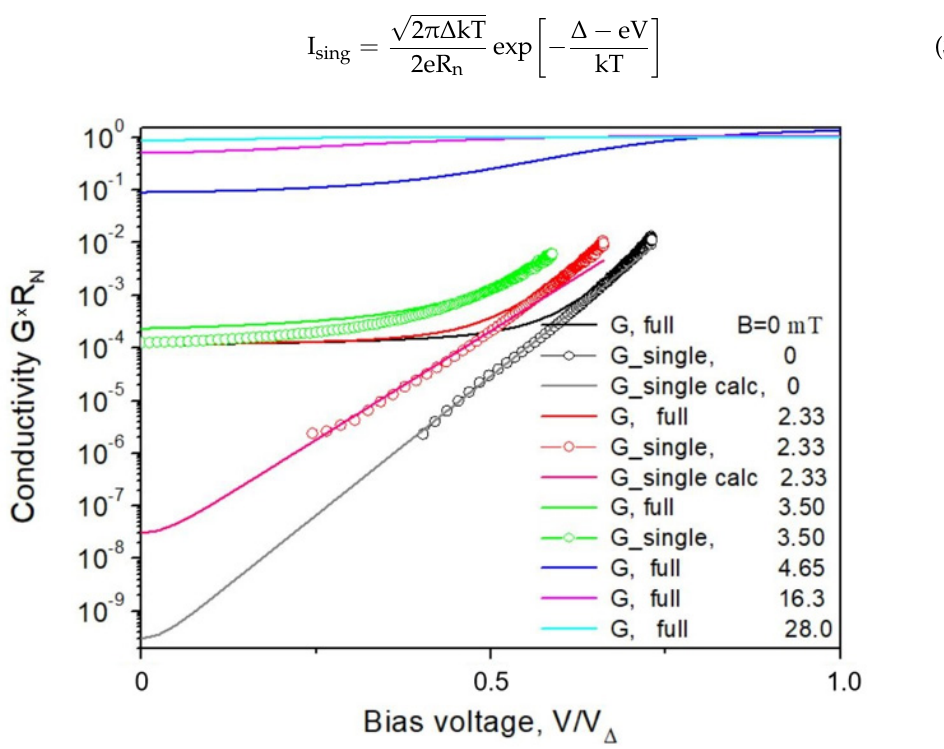
Figure 5. Normalized conductivity G × R n in logarithmic scale dependence (experimental with circles and calculated lines) on normalized voltage V/V ∆ for magnetic field from 0 to 28 mT. Curves with label “single” correspond to single-electron tunneling with subtracted Andreev current, and label “full” corresponds to full current including both Andreev conductivity and single-electron